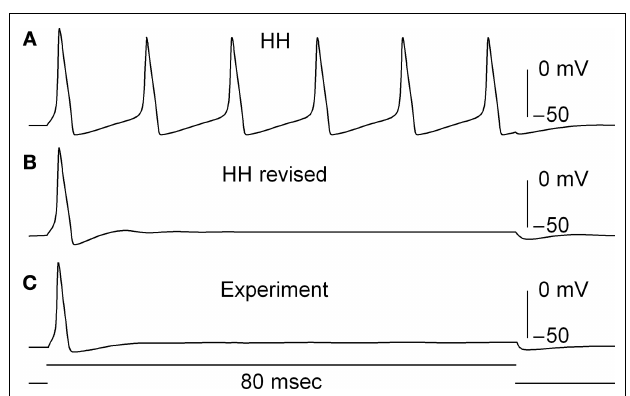
FIGURE 6 | Effect of GHK normalization of I in a model of squid axon K excitability. (A) Prediction of the response of the Hodgkin and Huxley (1952) model to a sustained depolarizing current pulse. The model fi res an unending train of action potentials. (B) Prediction of the revised model (Clay et al., 2008) with the modifi ed I activation curve given in Figure 5 . The revised model fi res K once and only once regardless of pulse duration or amplitude, similar to experimental observations, as illustrated in (C) .